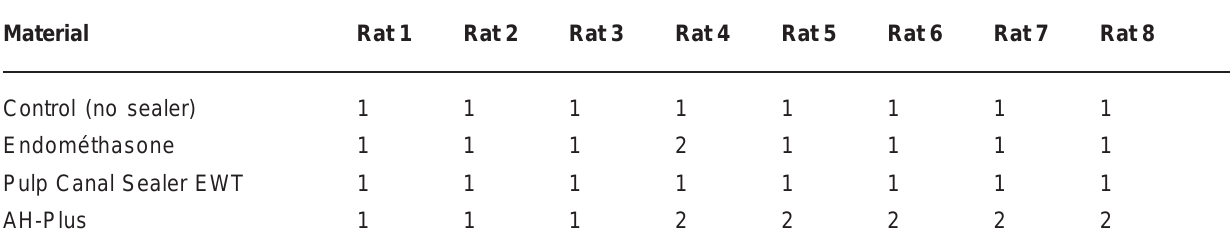
TABLE 5- Distribution of the scores attributed to the materials (Day 30)